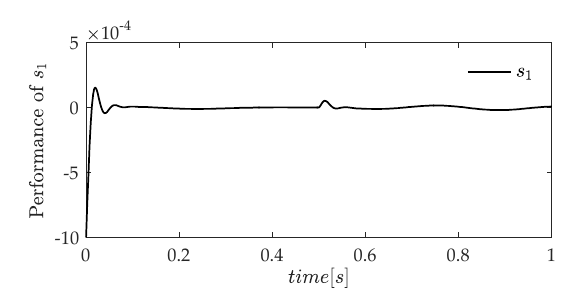
2 . Mathematics 2019 , 8 , 1371